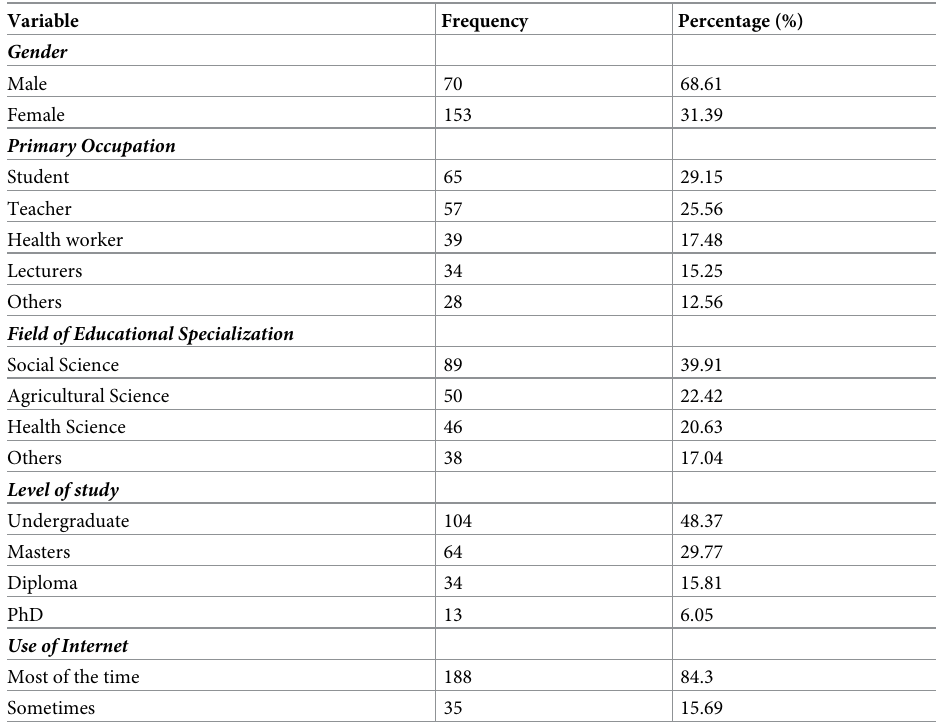
Table 1. General characteristics of